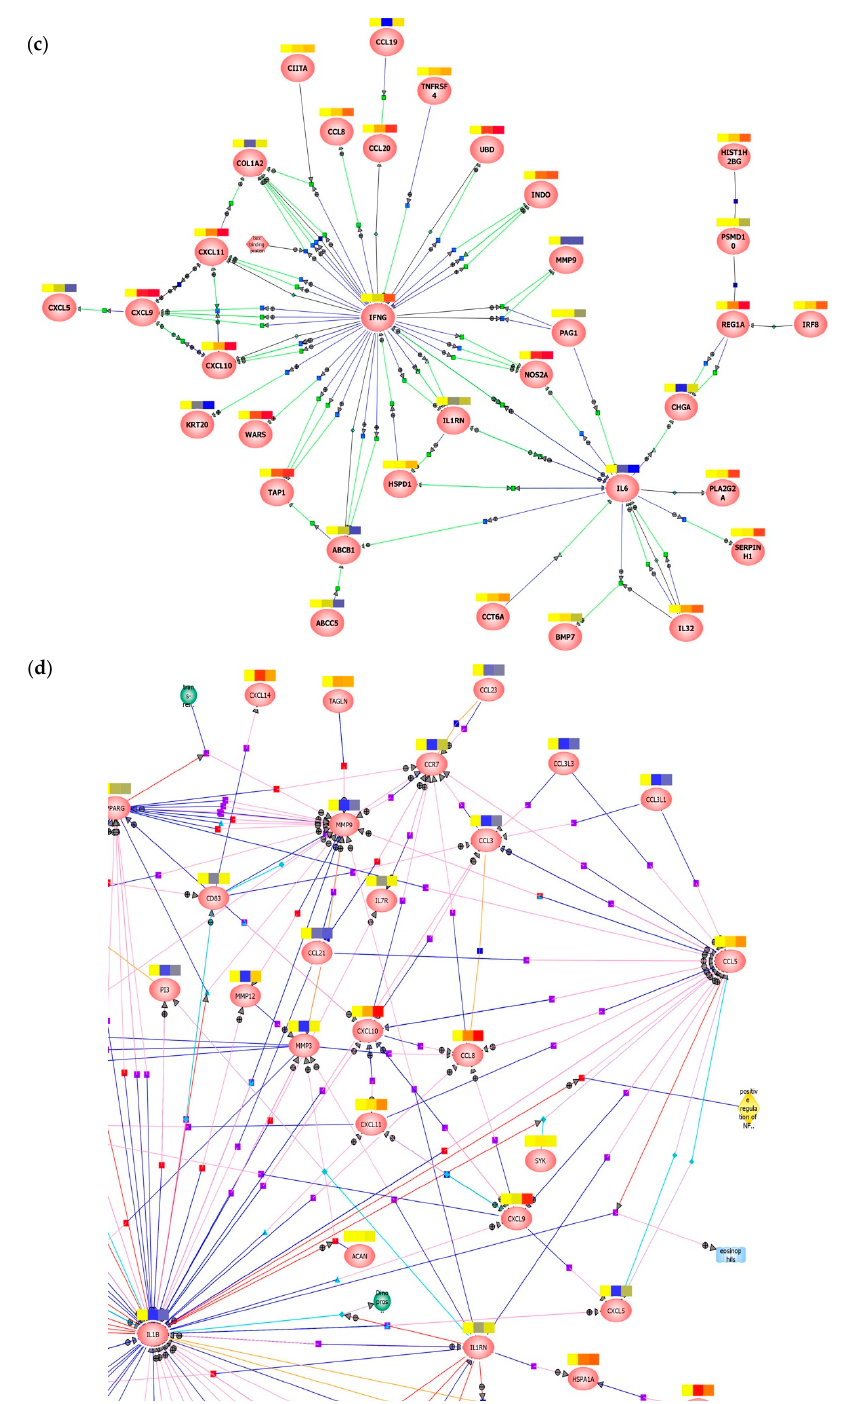
Figure 4. Transcriptomic analysis of HIV-1 YU.2 or NL4.3 ex vivo challenge of colorectal explants. RNA-microarray data from colorectal explants cultured ( a ) 6 or ( b ) 24 h post-ex vivo challenge was averaged by treatment and filtered on 1.5-fold change relative to the control. Hierarchical clustering was performed on data prior to averaging using uncentered correlation and average linkage. Columns represent individual samples and rows genes that are up (red) or downregulated (green). Interaction maps on genes across ( c ) 6 and ( d ) 24 h time points with a fold change greater than 1.5 in explants infected with either NL4.3 or YU.2 compared to untreated. The color swatches above each node indicate relative expression for the averaged treatment i.e., none (control), R5 (YU.2), X4 (NL4.3) left to right. Blue: downregulated; red: upregulated; yellow: unchanged. Data are shown from two independent